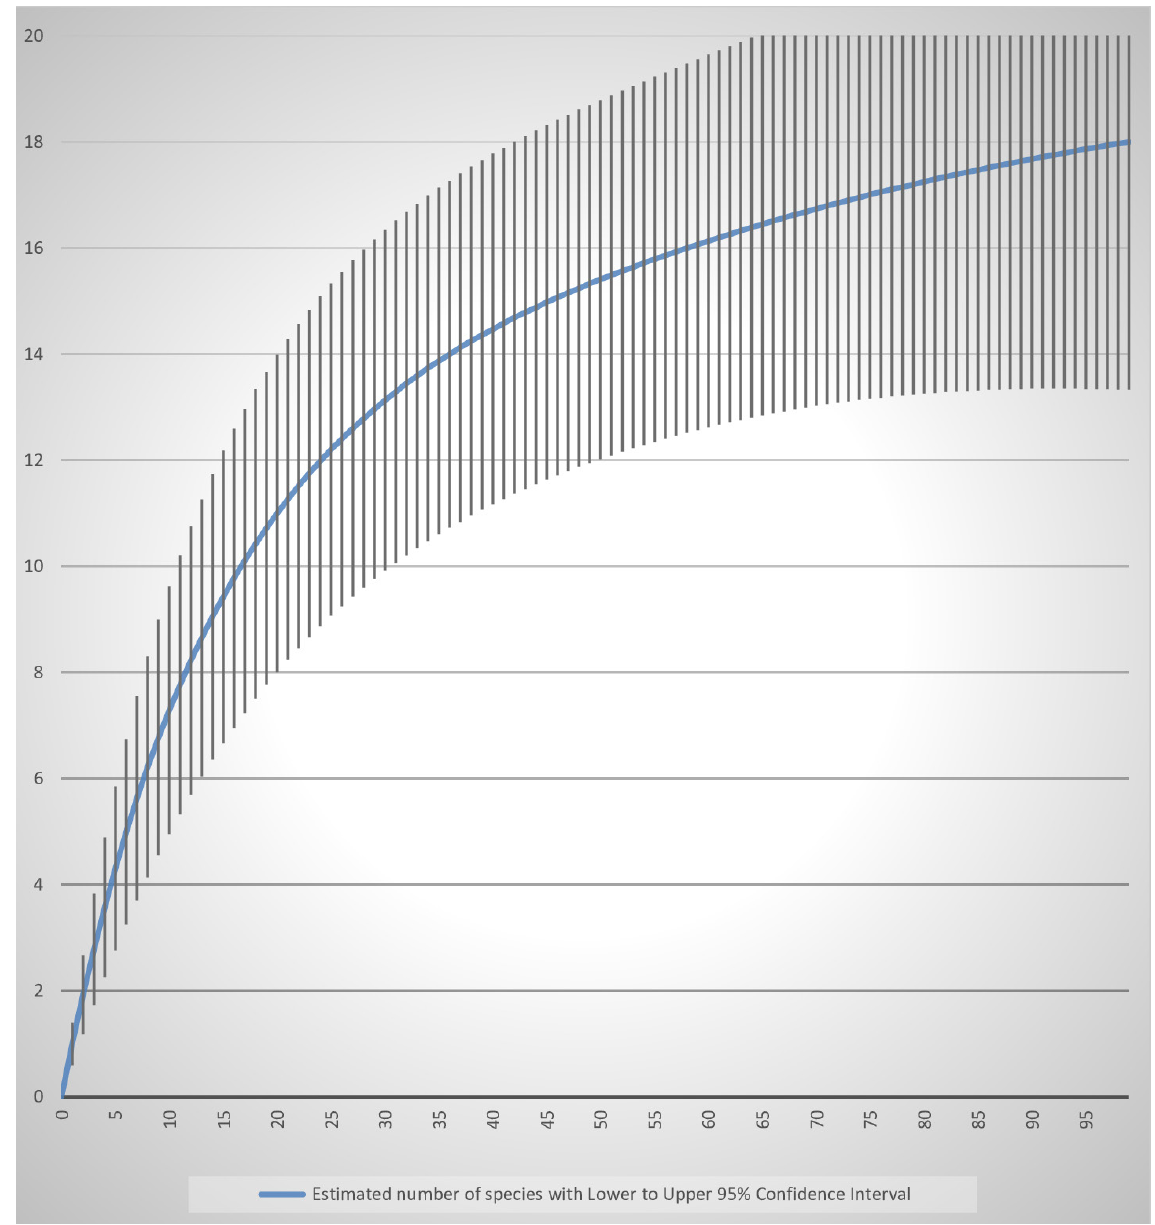
Fig. 52. Species estimation–extrapolated rarefaction curve. X-axis: cave location with species of Leucogeorgiini (each cave–species record counts separately); Y-axis: estimated number of